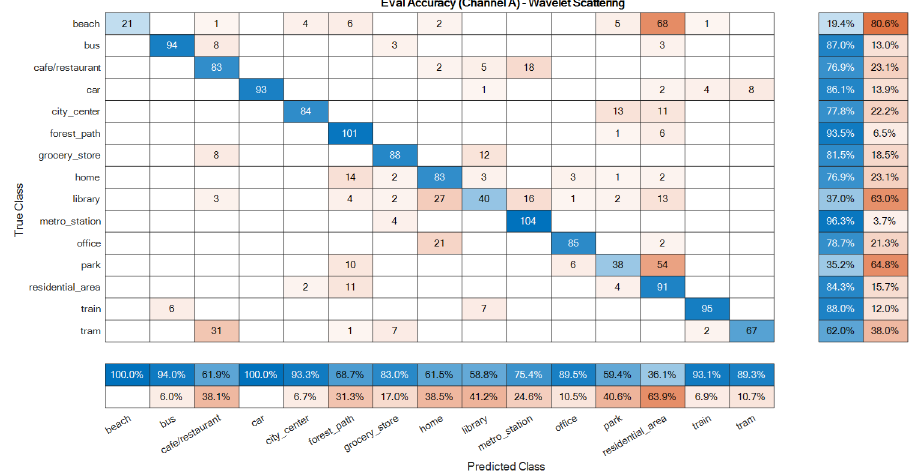
Figure 7. Ensemble classifier confusion matrix for the evaluation data: A